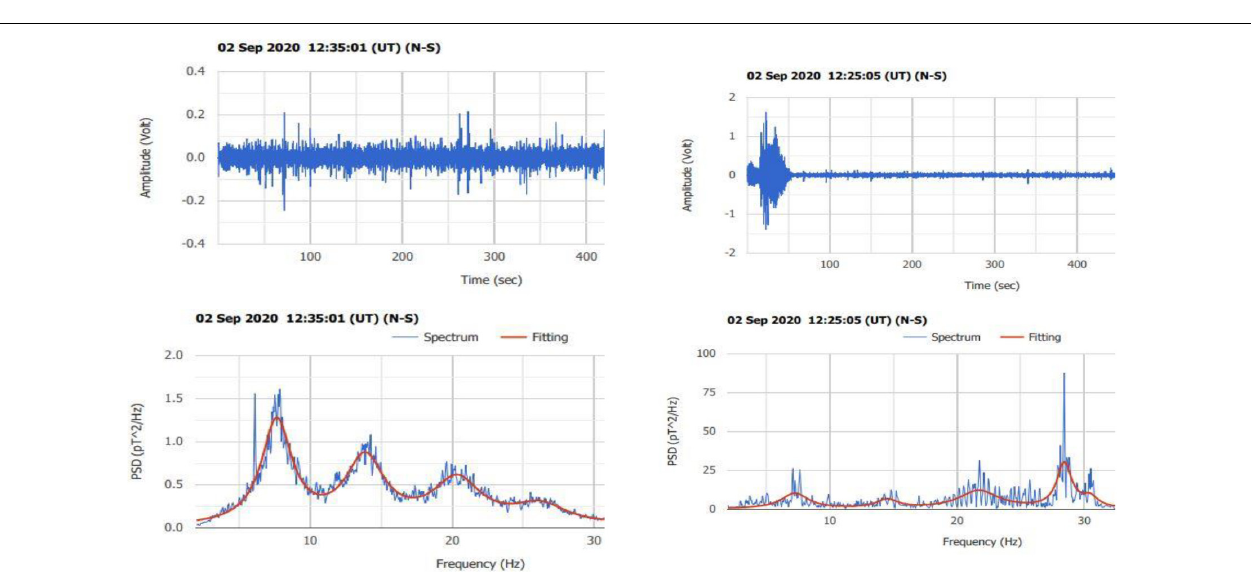
Frontiers in Earth Science |